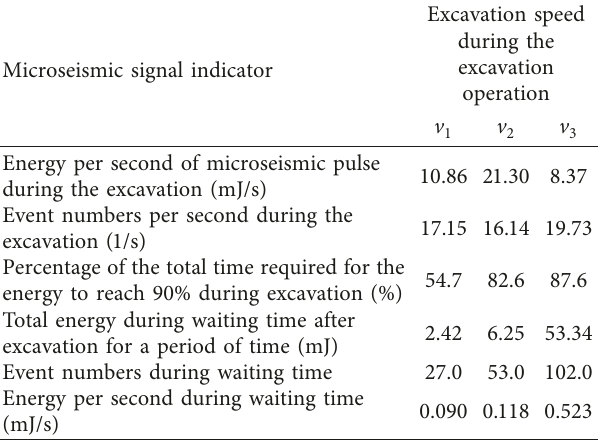
Excavation speed during